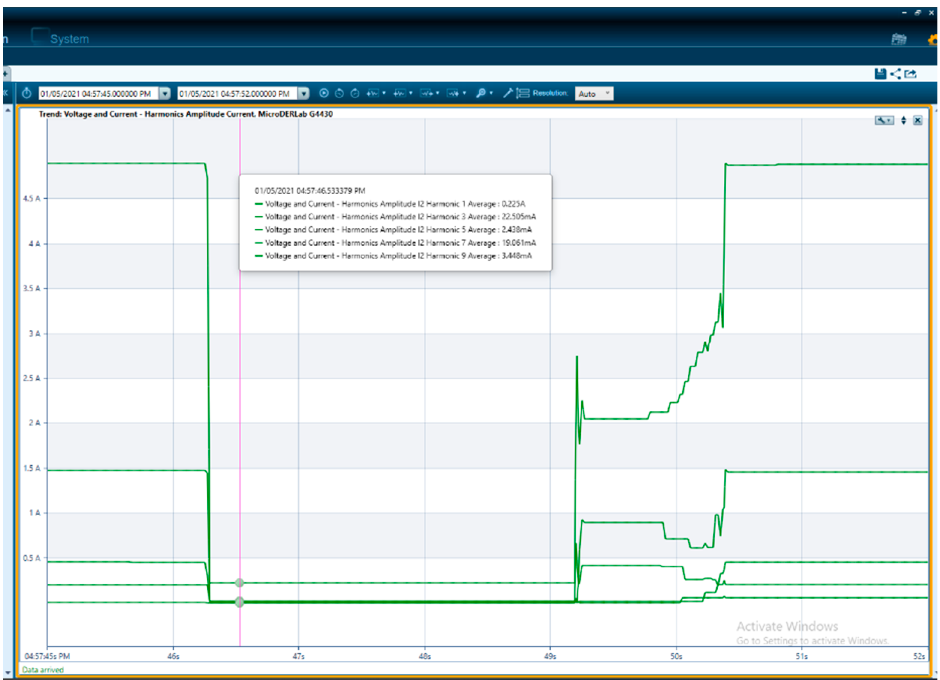
Figure 9. ( a ) Instantaneous frequencies and ( b ) amplitudes, of the mono-components extracted using the hybrid Hilbert- Huang method, of the microwave oven current described in Figure 6a.